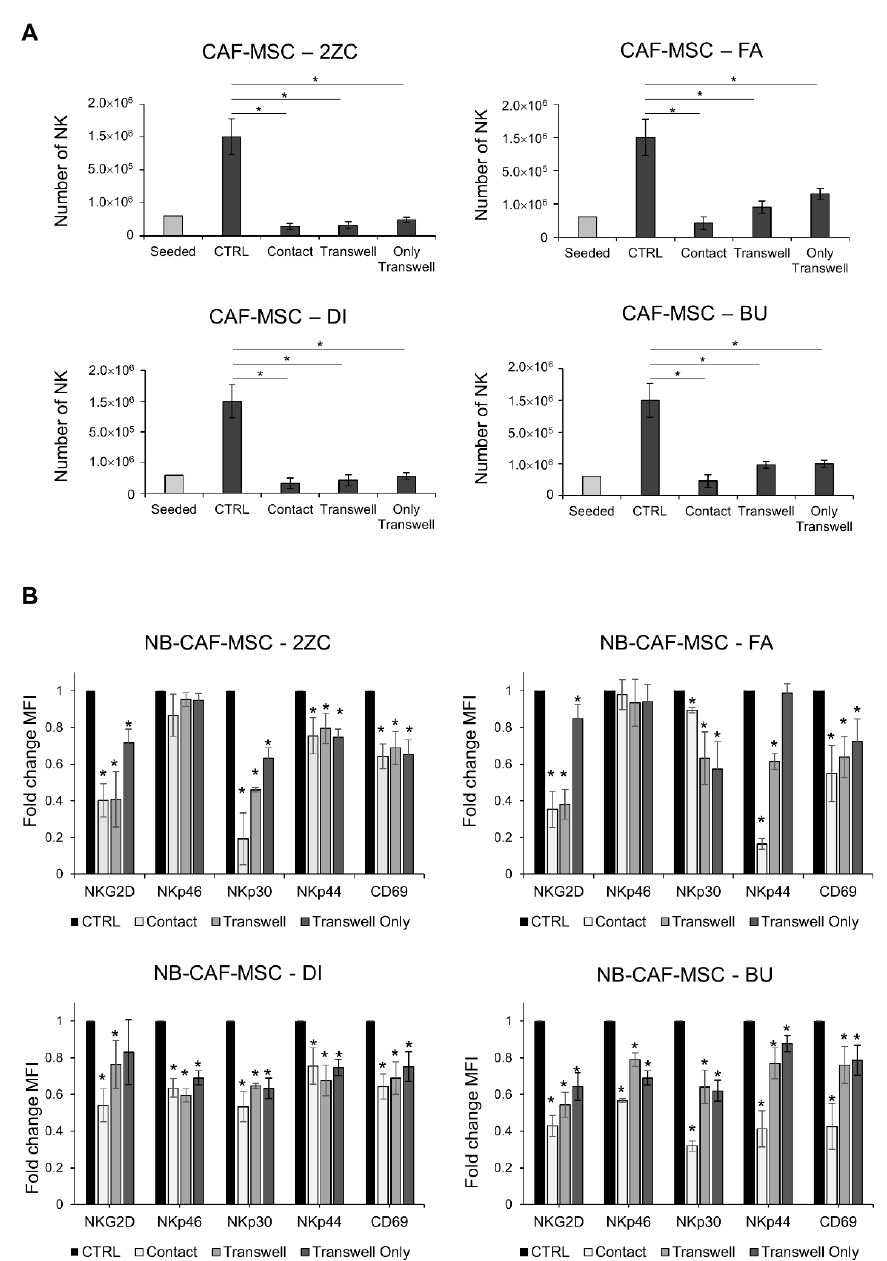
Figure 5. Evaluation of NK cell proliferative potential and downregulation of NK activating receptors after co-culture with primary NB-TA-MSC cultures. ( A ) Live NK cell number (PI − ) after co-culture with NB-TA–MSC primary cultures. Data were expressed as mean ± SD ( n = 6). * p < 0.05 vs. CTRL. ( B ) Flow cytometry analysis of the activating receptors present on NK cells after co-culture with the indicated young/proliferating NB-T-MSC primary cultures under direct cell–cell contact or under Transwell conditions. Data were expressed as Fold change MFI compared with CTRL ± SD ( n = 3). * p < 0.05 vs. CTRL.